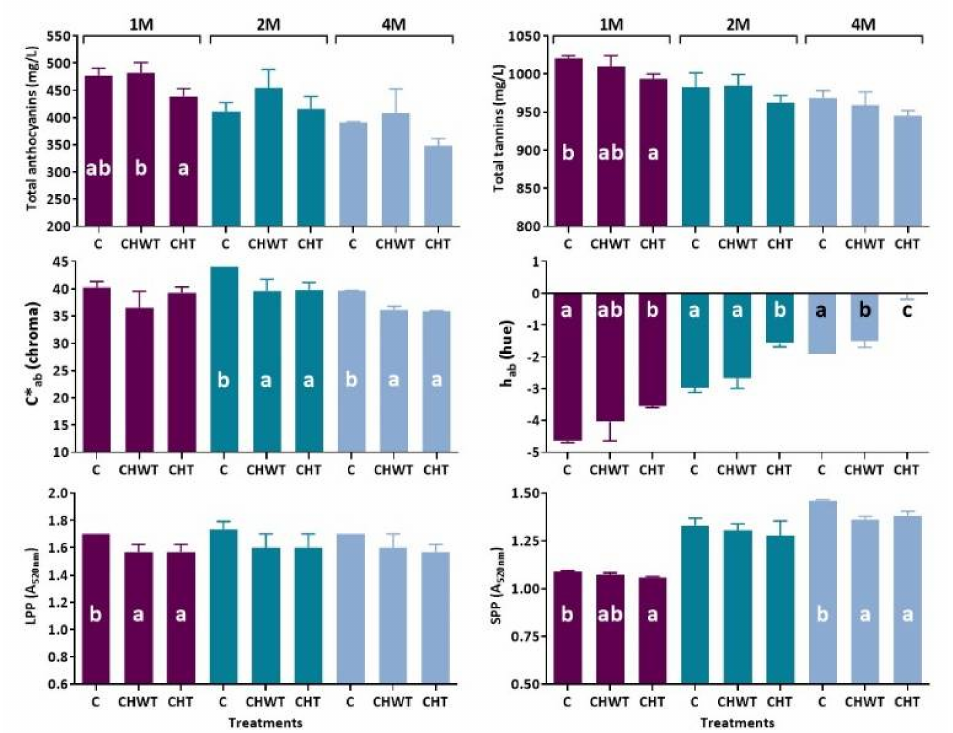
Figure 6. Global phenolic compositions and color parameters of Bonarda wines obtained by applying vine-shoots during aging. Different letters for each aging time indicate significant differences between treatments (Tukey’s HSD test, p < 0.05). C, control; CHWT, untoasted vine-shoot chips; CHT, toasted vine-shoot chips; 1M, 30 days; 2M, 60 days; 4M, 120 days; SPP, small polymeric pigments; LPP, large polymeric